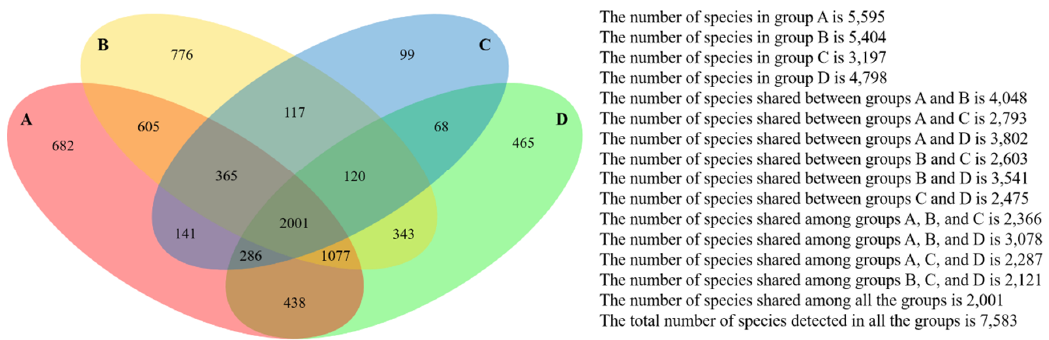
Figure 5. Commonness of forearm skin microbes across different groups. Four-way Venn diagram based on level 0.03 (97% similarity at species level) encloses all 30 datasets categorized in four groups,